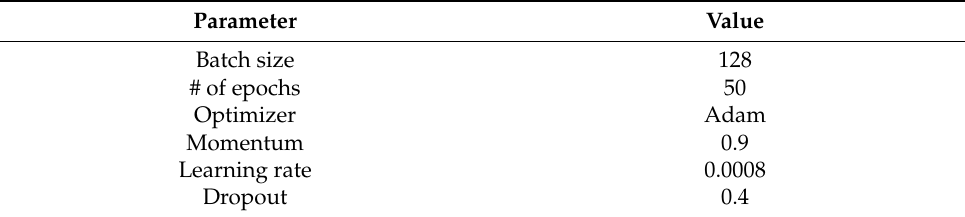
Table 3. Training parameters for variants of customized IR-v2.